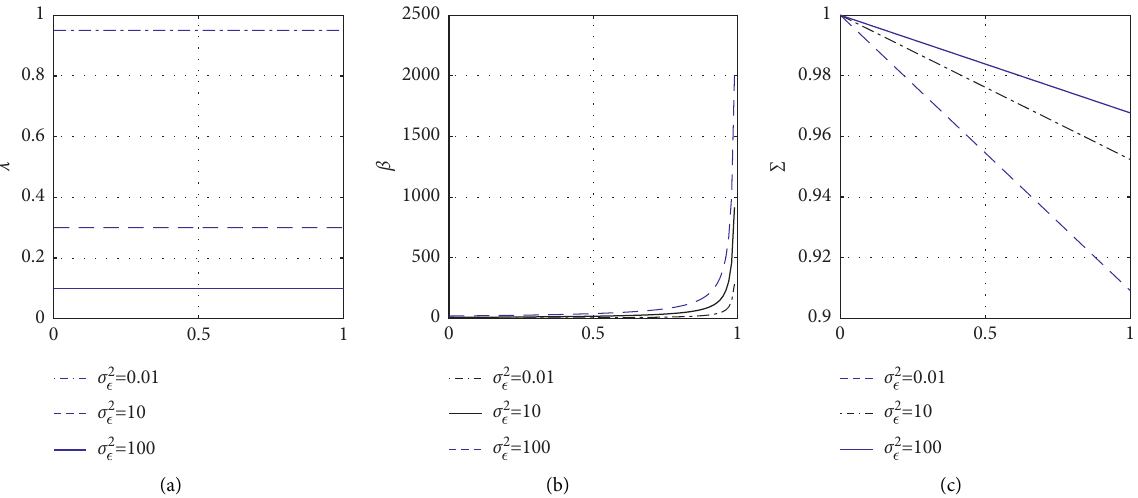
Figure 1: Market liquidity λ , trading intensity β , and residual information Σ noise in risk asset value. (a) λ varying with t . (b) β varying with t . (c) Σ varying with t .